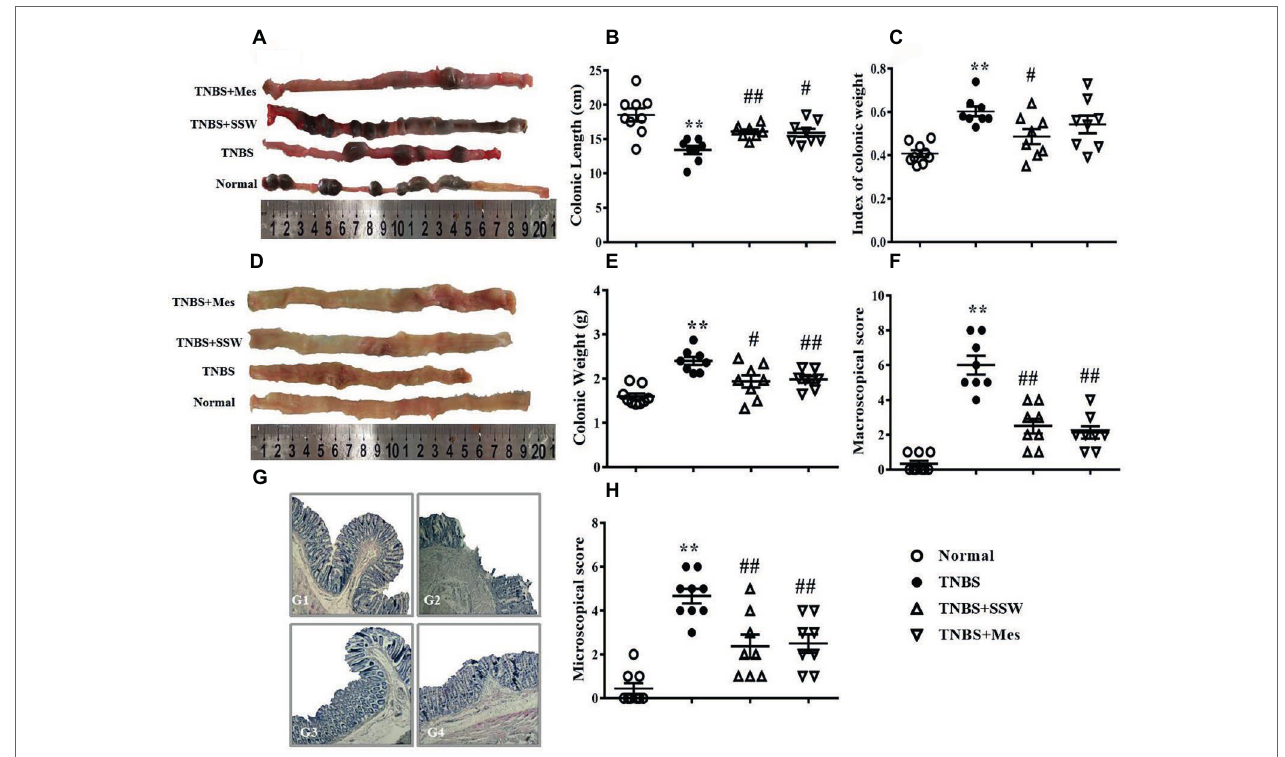
FIGURE 1 | Therapeutic evaluation of SSW-treated chronic colitis in rats. (A) Typical images of intact colon. (B) Colonic length. (C) Index of colonic weight. (D) Macroscopic view of the opened colon. (E) Colonic weight. (F) Macroscopic score. (G) Typical histological images stained by H&E, bar = 100 μ m. G1: the histological image of colonic tissue of a rat in the Normal group; G2: the histological image of colonic tissue of a rat in the TNBS group; G3: the histological image of colonic tissue of a rat in the TNBS+SSW group; G4: the histological image of colonic tissue of a rat in the TNBS+Mes group. (H) Microscopic score. Data are presented as mean ± SEM ( n = 8). * p < 0.05 and ** p < 0.01 versus the Normal group; # p < 0.05 and ## p < 0.01 versus the TNBS